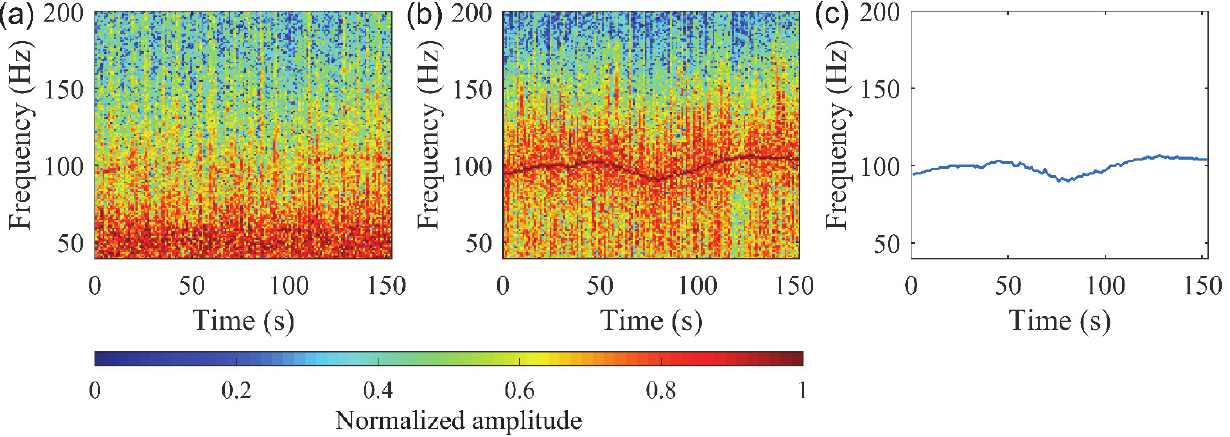
Figure 9. Time–frequency diagrams of the collected operational signal: ( a ) original signal; ( b ) TFAI ‐ EO ‐ ASR output signal; ( c ) dominant frequency extraction results.